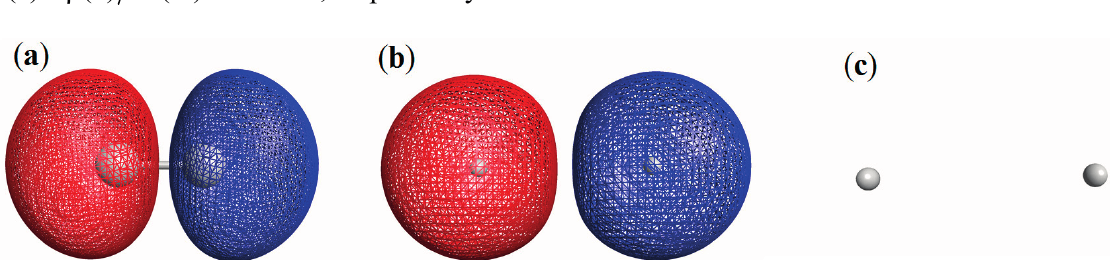
Figure 7. Equivalue surfaces of linear response functions for ( a ) H 2 , ( b ) He 22+ , and ( c